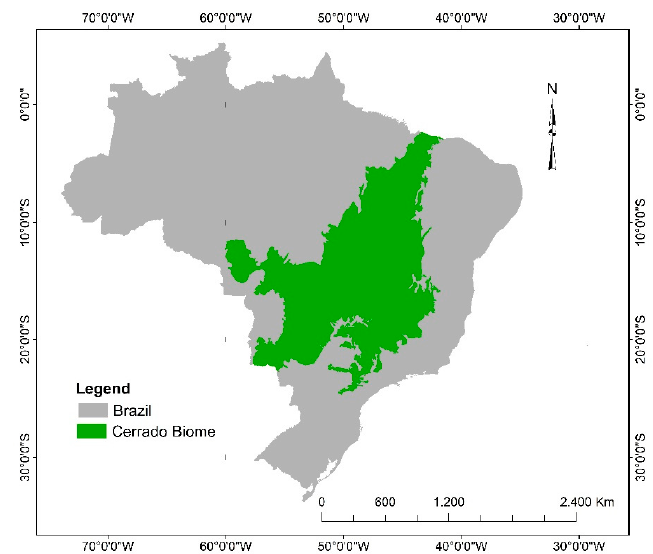
Brazil map highlighting the Cerrado biome [6]. Political Limit–Ministry of